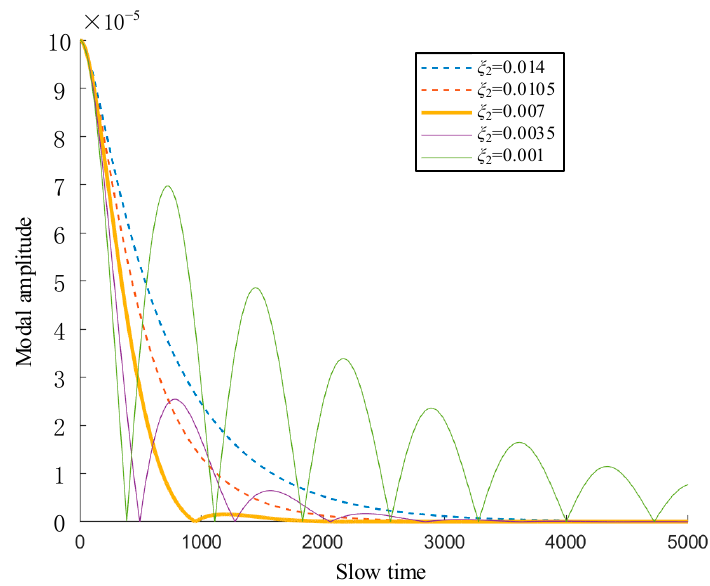
Figure 6. Influence of vibration absorber damping.